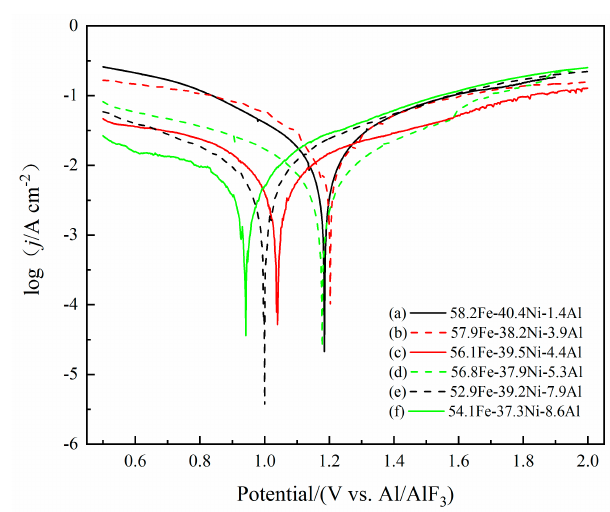
Figure 9. Tafel polarization curves of 58.2Fe-40.4Ni-1.4Al ( a ), 57.9Fe-38.2Ni-3.9Al ( b ), 56.1Fe-39.5Ni-4.4Al ( c ), 56.8Fe-37.9Ni-5.3Al ( d ), 52.9Fe-39.2Ni-7.9Al ( e ), and 54.1Fe-37.3Ni-8.6Al ( f ) alloys measured in 39.3NaF-43.7AlF 3 -8NaCl-5CaF 2 -4Al 2 O 3 melts at 850 °C (scan rates 0.01 V·s − 1 ; vs. Al/AlF 3 ). Table 4. Corrosion parameters of Fe-Ni-Al alloy anodes measured in 39.3NaF-43.7AlF 3 -8 NaCl-5CaF 2 -4Al 2 O 3 melts at 850 °C.